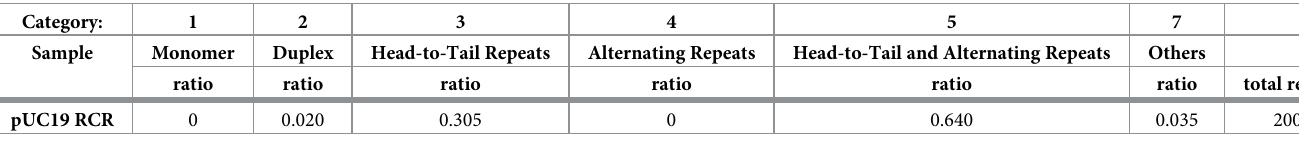
Table 2. Read analysis data of Phi29 polymerase mediated RCR of pUC19 DNA. Category: